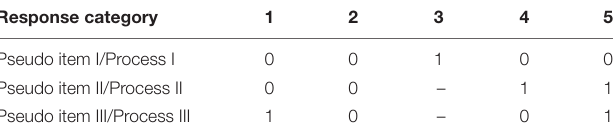
TABLE 2 | The decomposition method of a 5-point